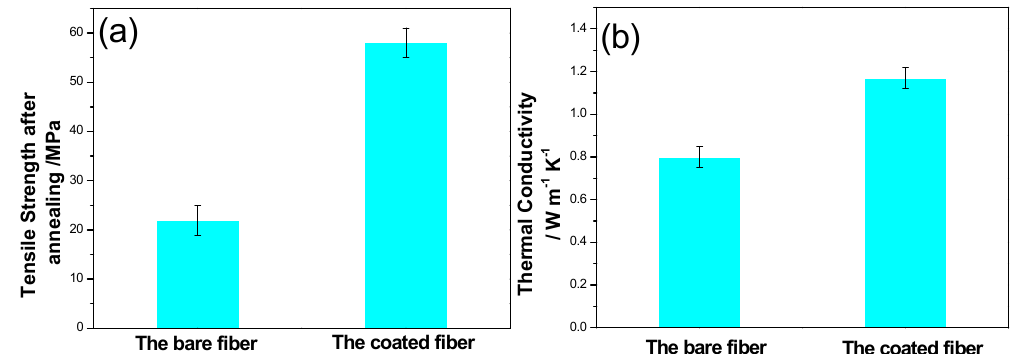
Figure 5. The tensile strength ( a ) and the thermal conductivity ( b ) of the bare and the coated quartz fibers.